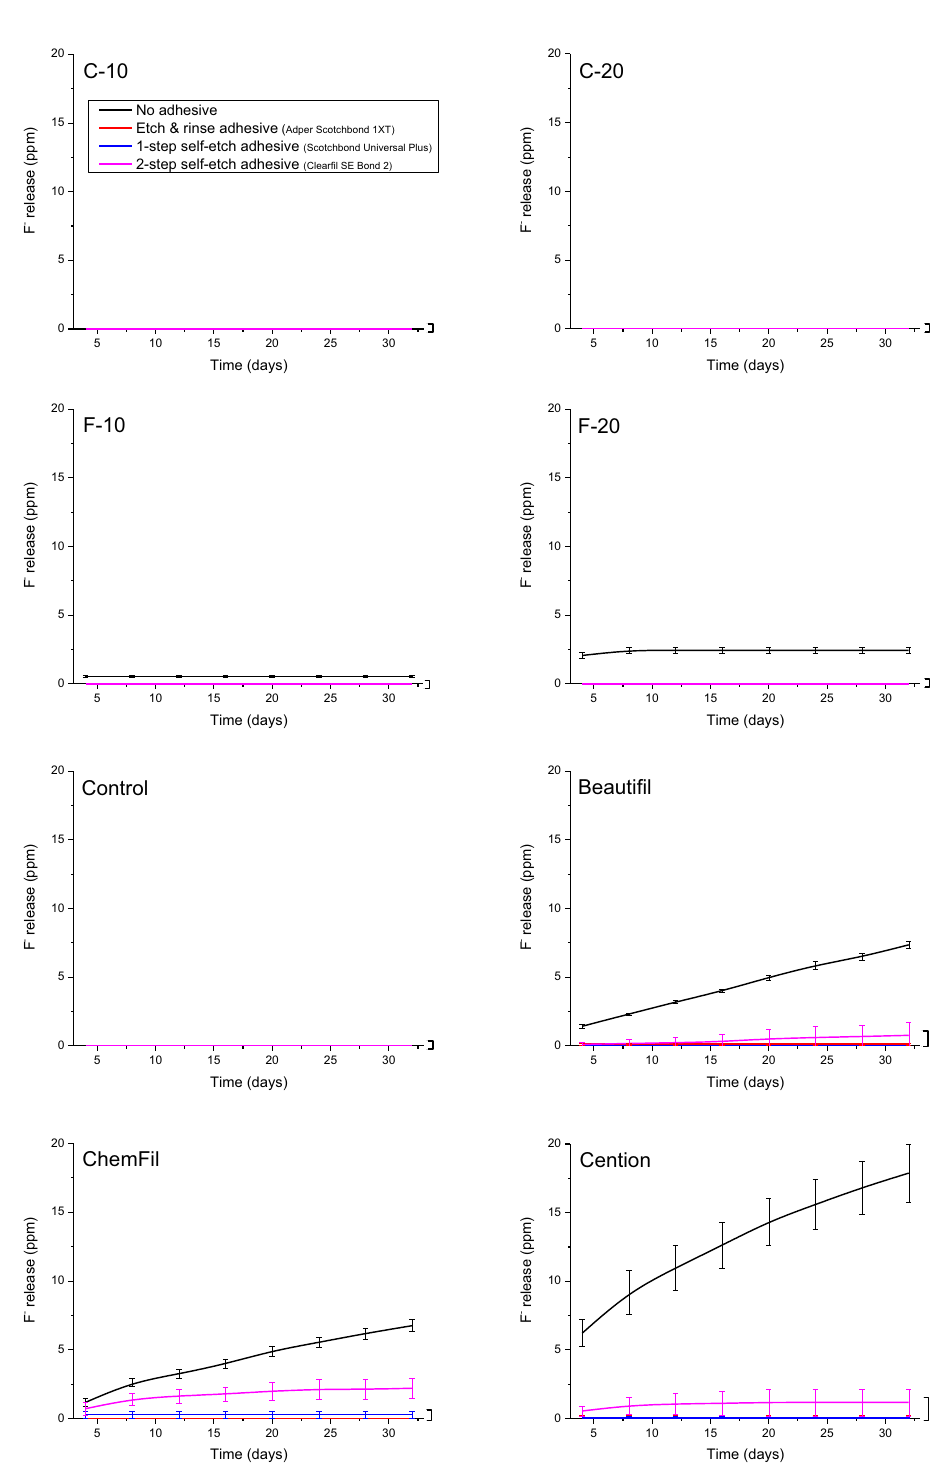
Figure 4. Cumulative concentrations of fluoride ions measured in lactic acid solution over 32 days. Square brackets indicate statistically similar values at the end of the observation